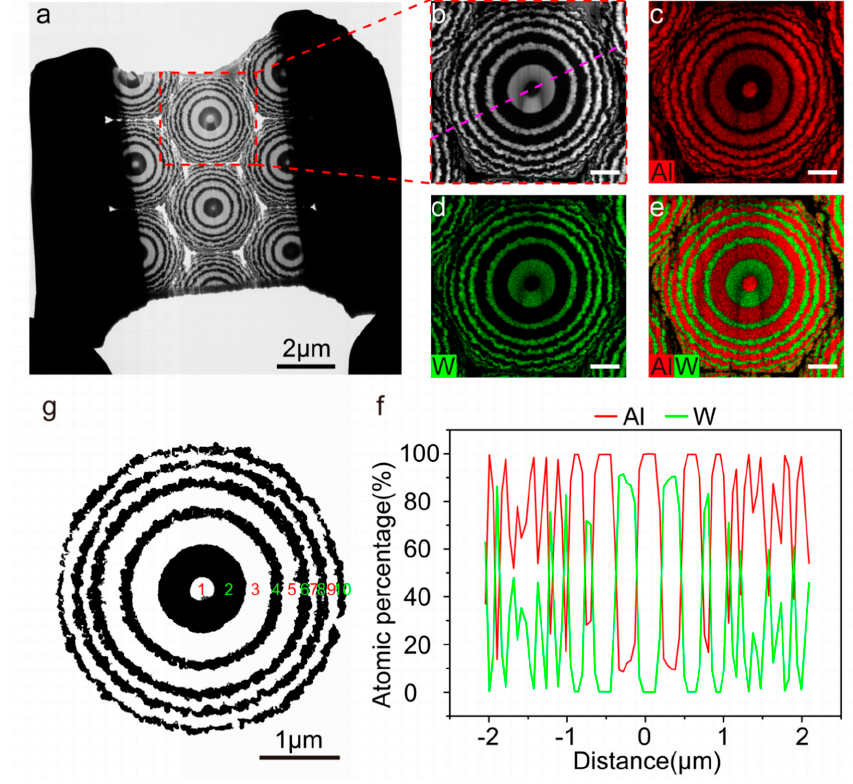
Figure 4. Elemental analysis of single concentric ring unit. ( a ) TEM image of specimen. The section z = 1.83 µ m with W-and-Al alternating rings printed is intercepted by FIB and the thickness of specimen is less than 100 nm. ( b ) HAADF-STEM image of single concentric ring unit shown in red dotted box of ( a ). EDX elemental mapping images of Al ( c ), W ( d ), and their overlap ( e ) are shown. ( f ) Material distribution curves along the purple dotted line shown in ( b ). Scale bar: 500 nm in ( b – e ). ( g ) Post-processing material distribution including ten concentric rings using MATLAB software. Material distribution is extracted from TEM image of specimen ( a ) using image processing technology and clearer boundaries are shown. Al (white)-and-W (black) alternative concentric rings are labeled 1 to 10 in